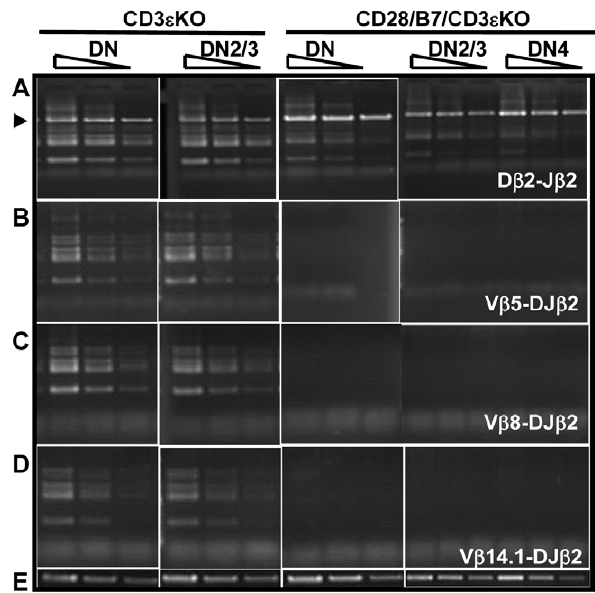
Figure 2. CD28/B7-driven development inhibits TCR b rear- rangement in DN thymocytes. 100, 30, and 10 ng of DNA was analyzed by PCR to detect (A) D b 2-J b 2 rearrangement, (B) V b 5-DJ b 2 rearrangement, (C) V b 8.1-DJ b 2 rearrangement, or (D) V b b14.1-DJ b 2 rearrangement. (E) 10, 3, and 1 ng of DNA was analyzed by PCR to detect unrearranged IgM as a loading control. The arrow in panel A denotes the amplification of germline or non-rearranged D b 2-J b 2 PCR products. These results presented here comparing VDJ b rearrange- ments in CD3 e and CD28/B7/CD3 e KO DN cells were analyzed in the same experiment and are representative of three experiments analyzing DNA prepared from a total of six CD3 e KO and CD28/B7/CD3 e KO mice.